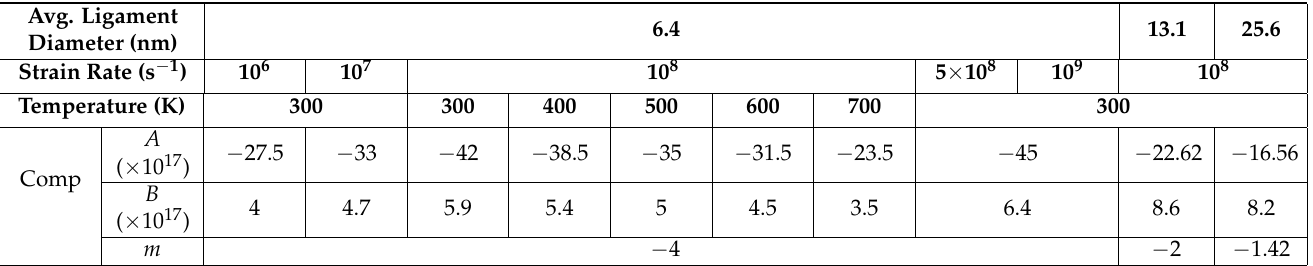
Table 2. Equation (2) parameters values according to Saffarini et al.